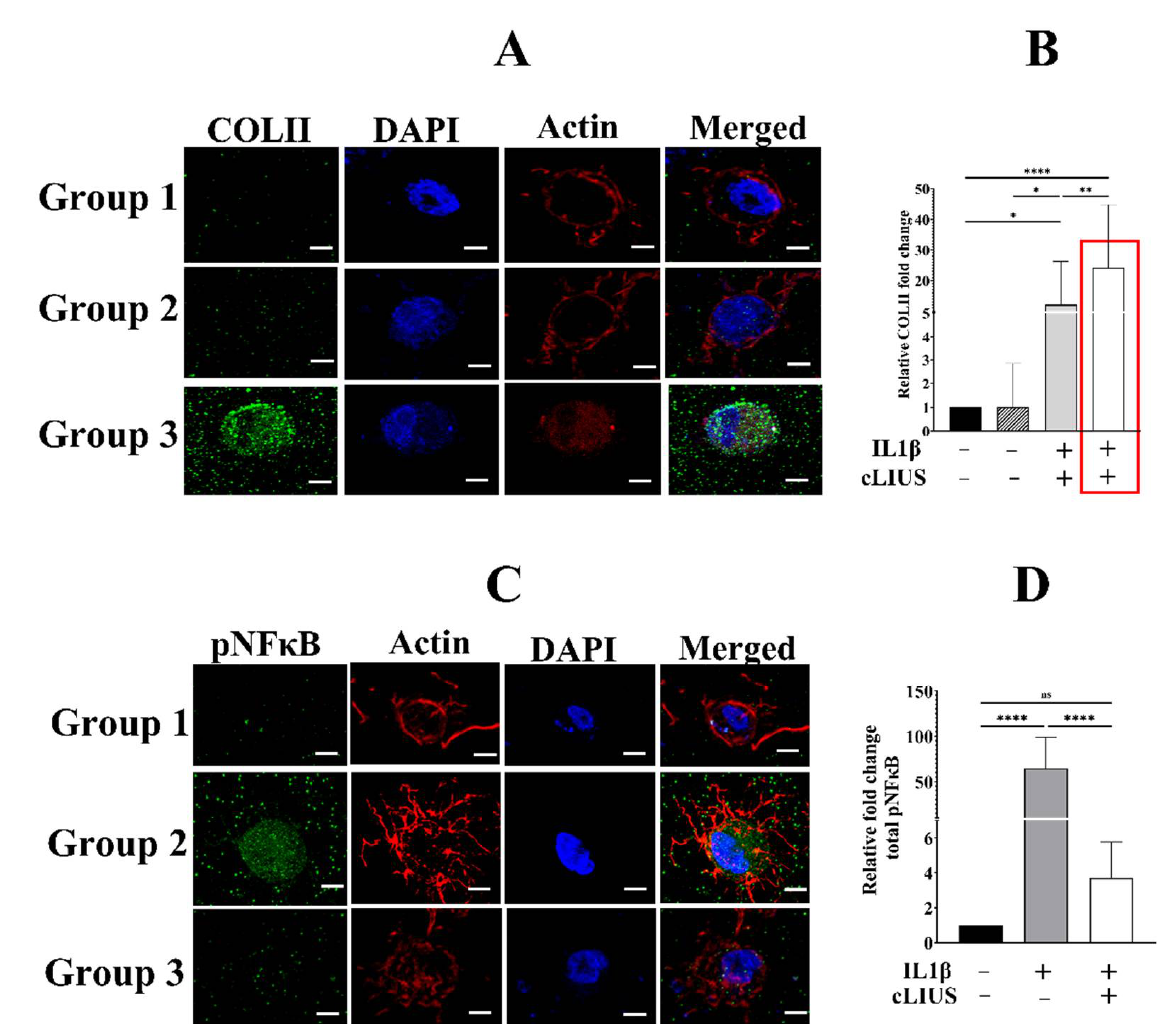
Figure 2. Localization of pNFκB and COLII and gene expression analysis in hydrogel scaffolds. At the end of 21 days of culture, hydrogels were subjected to both gene expression and IF analysis. Briefly, hydrogels were fixed using 4% PFA in HBSSCM and stained against COLII and pNFκB (green fluorescence), respectively, in separate experiments ( A , C ), and nuclei were counter stained with DAPI (blue fluorescence). Z stacks of the hydrogels were captured using the Zeiss LSM 700 confocal microscope with 63× magnification (z step size 5 µm), and fluorescence intensity ( B , D ) was quantified using ImageJ TM software ( n = 30). Data are shown as the mean ± standard deviation of samples and p -value represents statistical significance (* p < 0.05; ** p < 0.01; **** p < 0.0001 and ns-nonsignificant) and scale bar represents 5 µm. ‘+’ indicates presence and ‘–’ indicates absence.